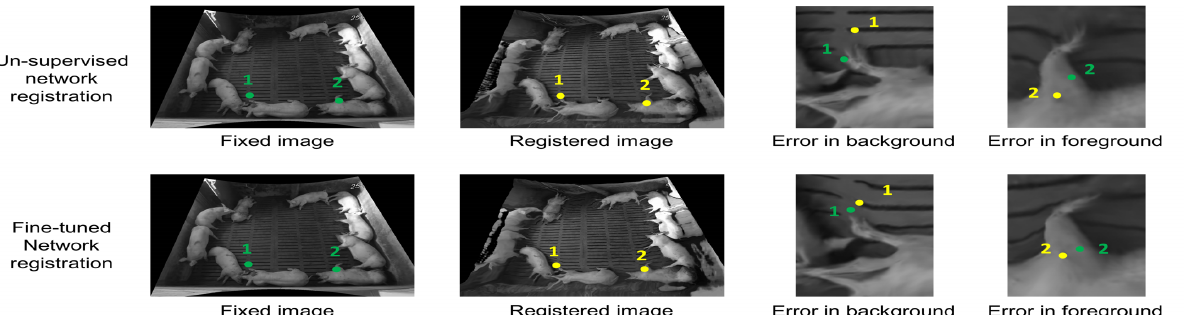
Figure 7. Illustrations of non-linear dense registration effects and errors of un-supervised and fine-tuned networks in surveillance of a pen with